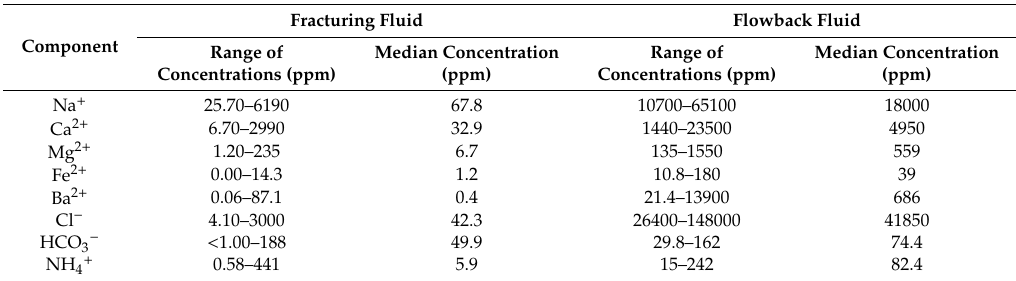
Table 1. Comparison of concentrations of the most important components in fracturing fluid and flowback fluid from the Marcellus Shale